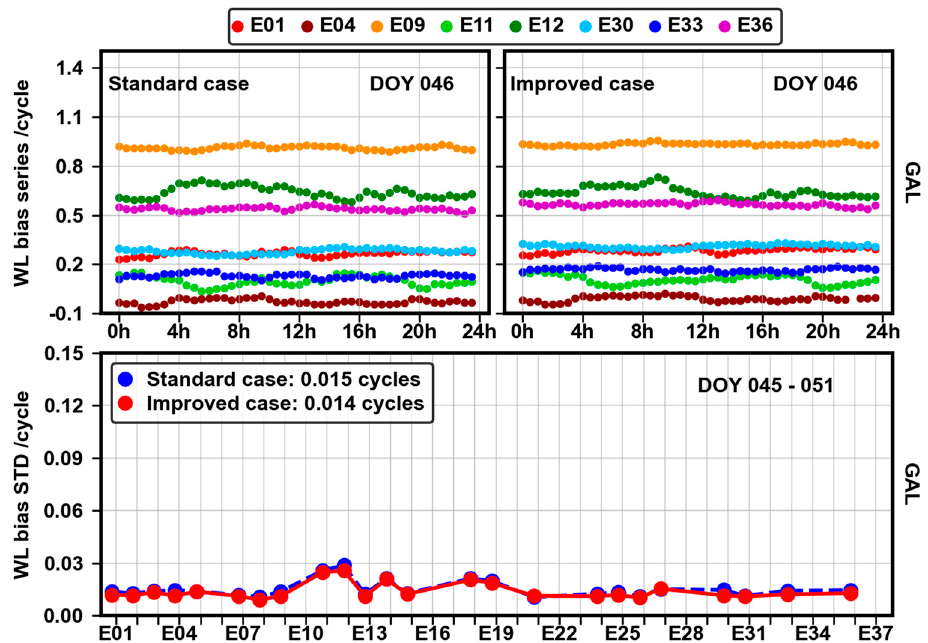
Figure 11. WL phase bias series on DOY 46, 2021 and the corresponding STDs across 7 days for Galileo for the standard case and improved case for the Case 4